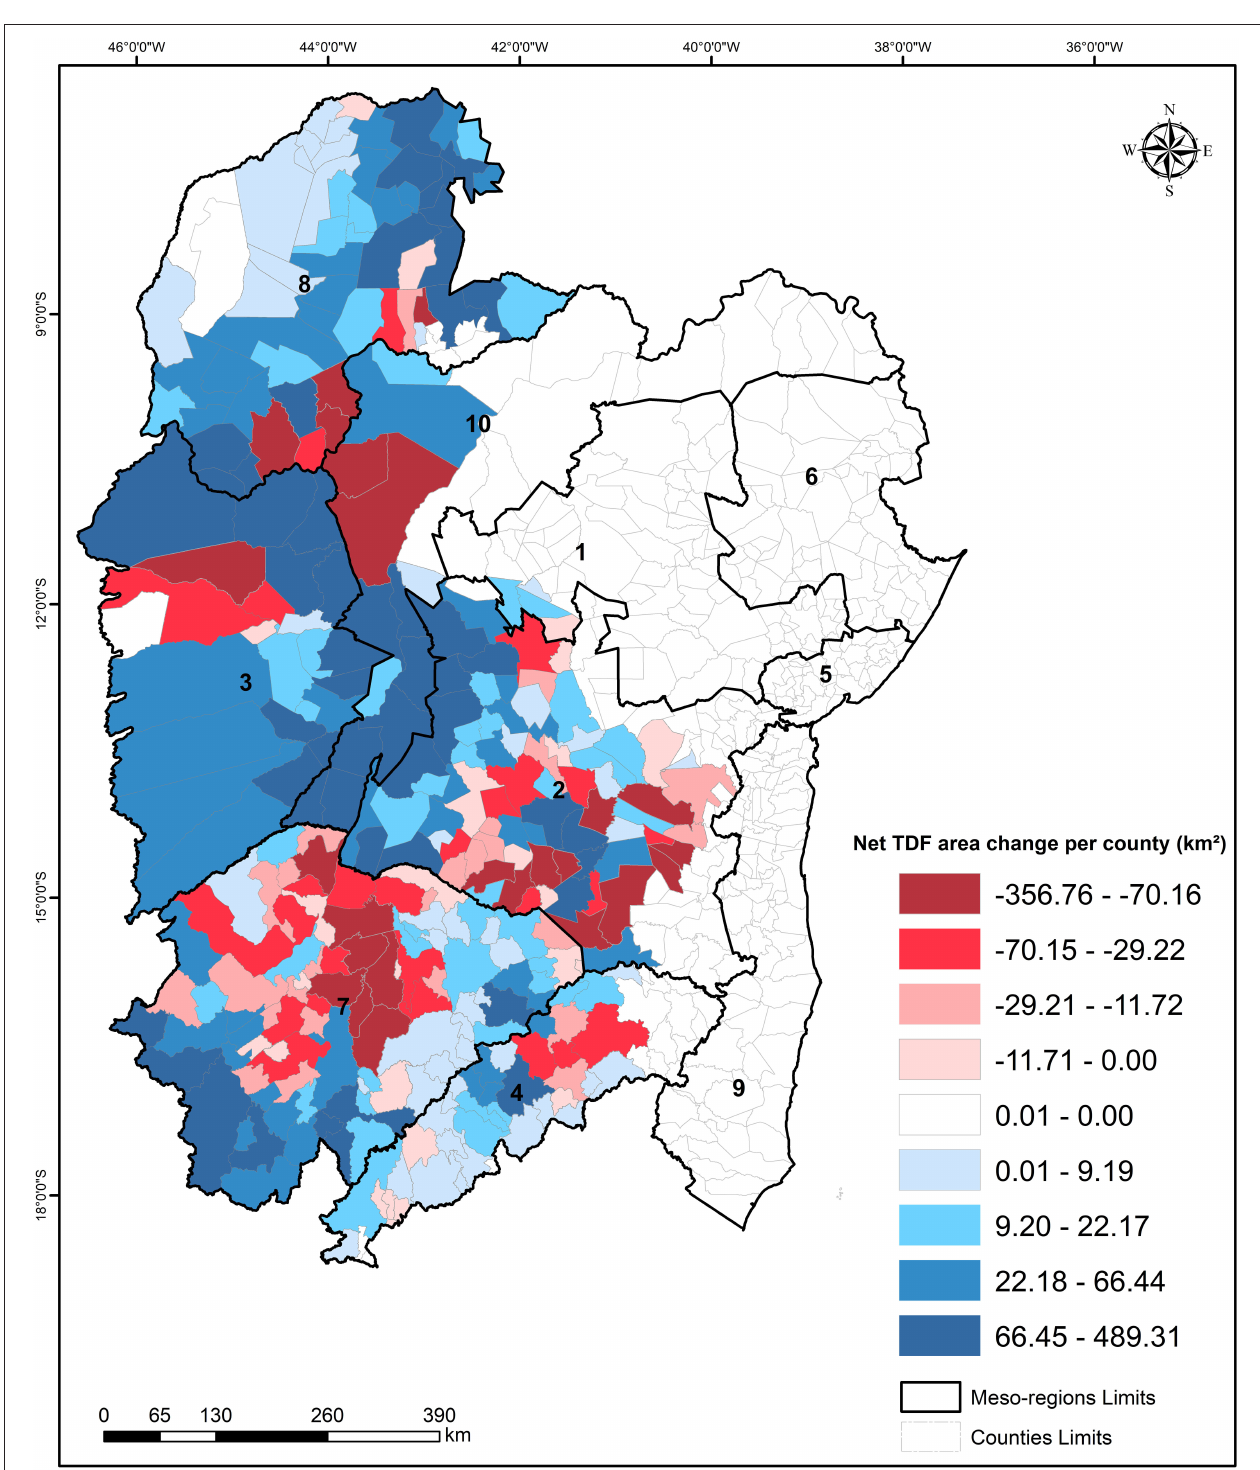
FIGURE 3 | Net change in tropical dry forest (TDF) cover along the 619 counties in each of 10 meso-regions, encompassing three Brazilian states (Minas Gerais, Bahia and Piauí). 1 = Central-North of Bahia; 2 = Central-South of Bahia; 3 = Far West of Bahia; 4 = Jequitinhonha; 5 = Metropolitan Region of Salvador; 6 = Northeast of Bahia; 7 = North of Minas Gerais; 8 = Southwest of Piauí; 9 = South of Bahia; 10 = São-Francisco Valley of Bahia. The eight classes of net change, from net deforestation in red to net regeneration in blue, were defined based on four positive and negative quartiles for the 619 counties.